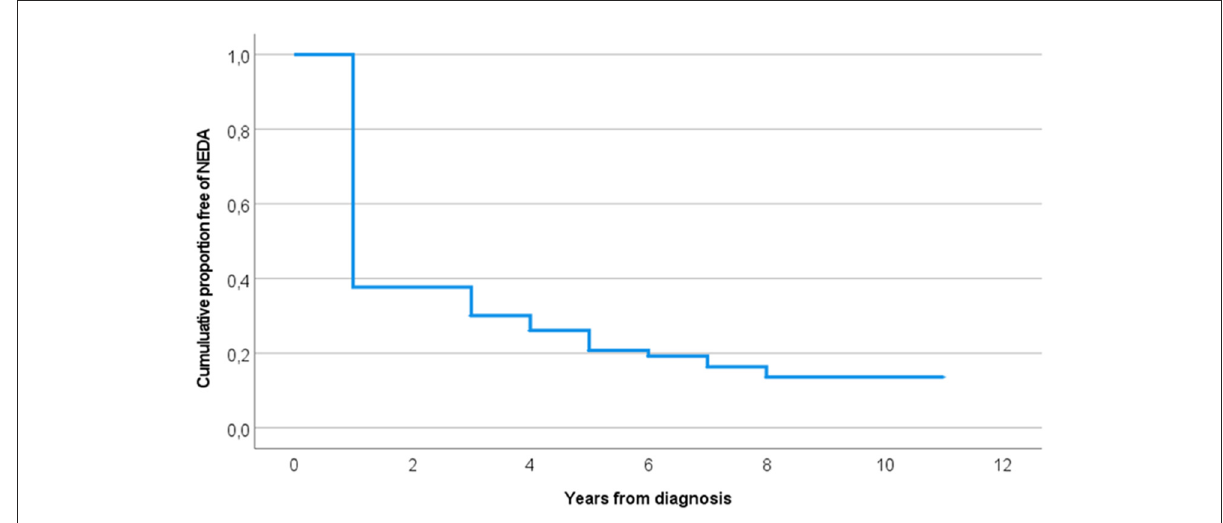
FIGURE3 Time to NEDA fail in years. NEDA no evidence of disease